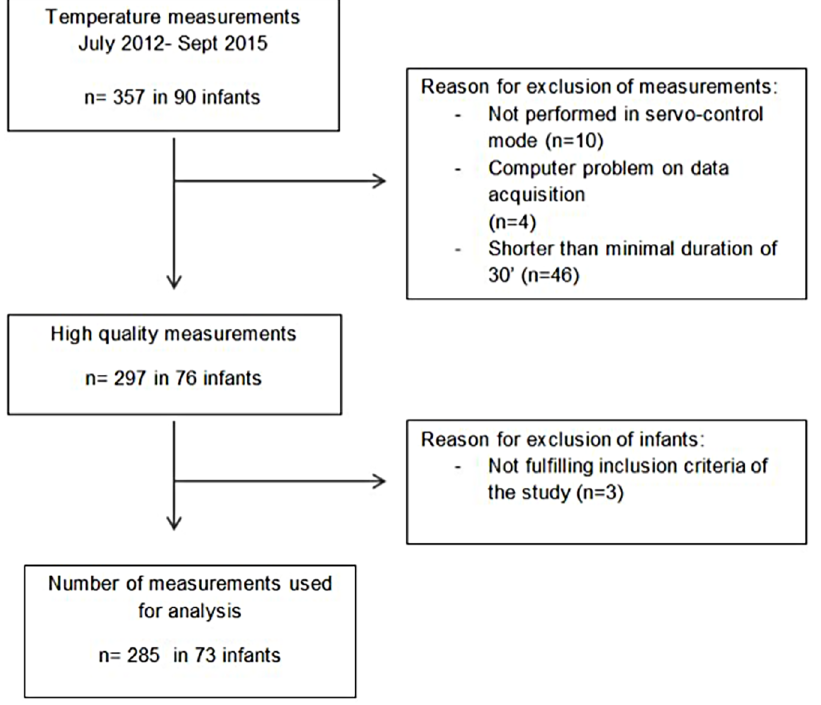
Fig 1. Flow of patients and measurements through the phases of the